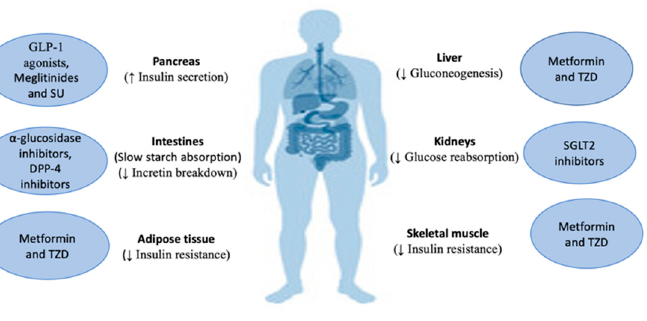
Figure 2. Mechanisms of action of hypoglycemic agents: dipeptidyl peptidase-4 (DPP-4); glucagon- like peptide 1 (GLP-1); sodium-glucose co-transporter-2 (SGLT2); sulfonylureas (SU); thiazolidinediones (TZD).